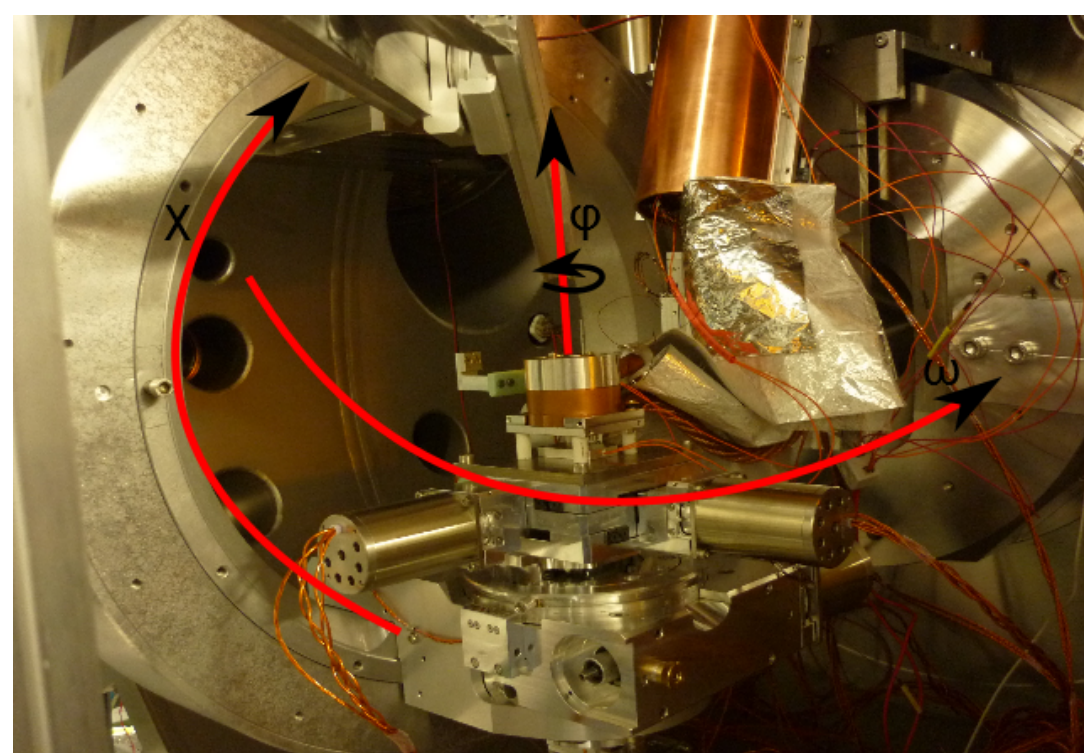
Figure 1: Di ff ractometer in the vacuum